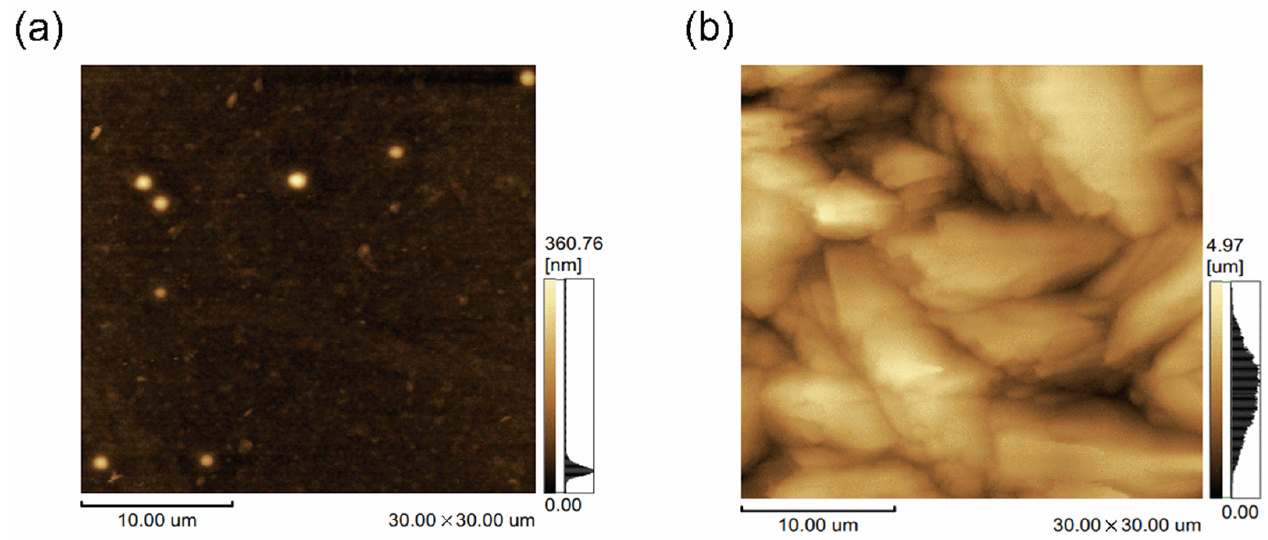
Figure 6. AFM images of ( a ) P700 ( b ) P400 parylene films. The surface roughness values ( R q ) and peak-to-valley values of the P700 and P400 films are 17.6 nm, 332.1 nm, 817.7 nm, and 4440 nm, respectively, indicating a large difference in the surface roughness values. This can be attributed to the difference in crystallinity, as revealed in the previous SEM results. It was expected that the surface of the other visible films would also be several hundreds of nanometers rougher than the P700 film. A very small amount of crystal fragments is also observed in the P700 film, which can be attributed to some uncleaved dimer crystals since the same vaporization and pyrolysis chambers were used to produce the P400 film. However, these crystals were so small that they did not have a significant effect on the optical and physical properties of the P700 film. Pyrolysis at low temperatures in the range of 400–500 °C forms opaque parylene films due to the low dimer-cleavage rate. This can be confirmed through the transmittance and haze analysis of the visible parylene films. According to previously reported results, the P700, P500, P450, and P400 films showed a total transmittance of 80% or more at 550 nm